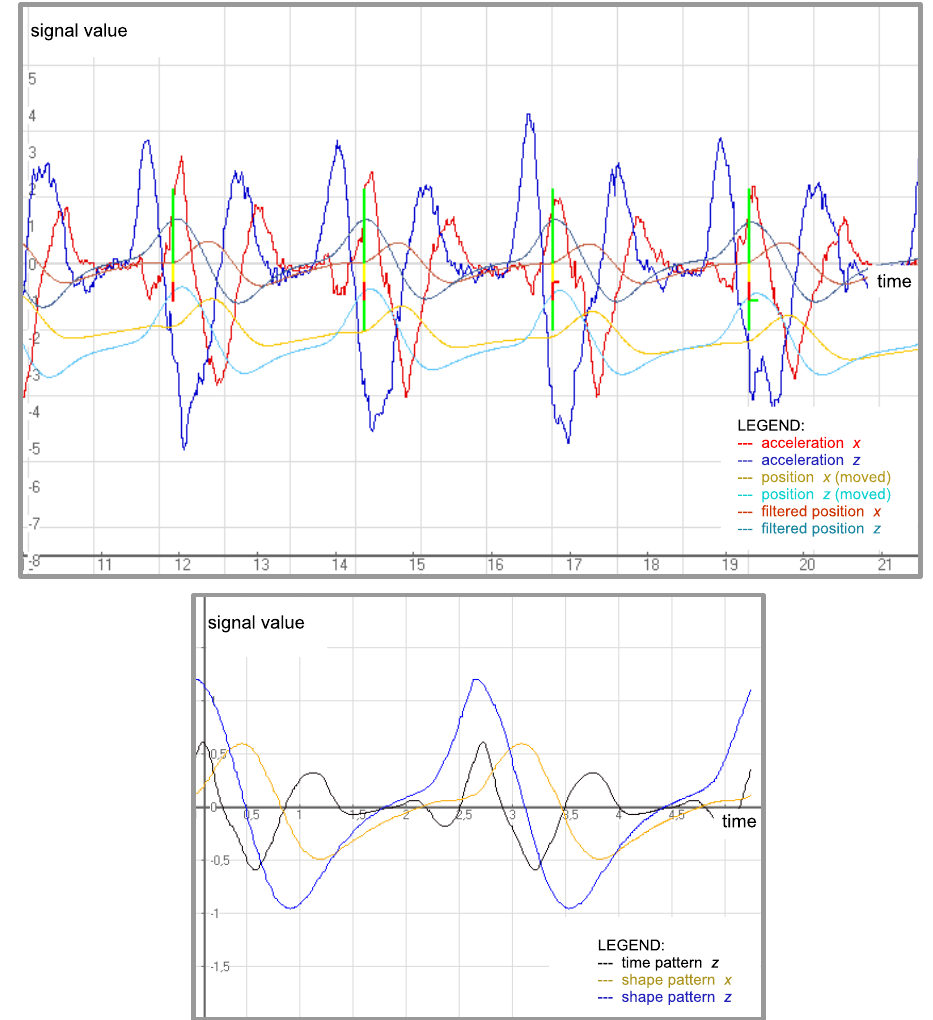
Figure 4. Signals and patterns created from the signals. For example, the red signal in the upper window represents the x component of acceleration. The unit of the vertical axis is 1 m/s 2 , and the time axis is scaled in seconds. The bottom window depicts the time pattern (black) created from the x component of acceleration on the base of several periods depicted in the top. Two shape patterns created from the x and z components of position are also